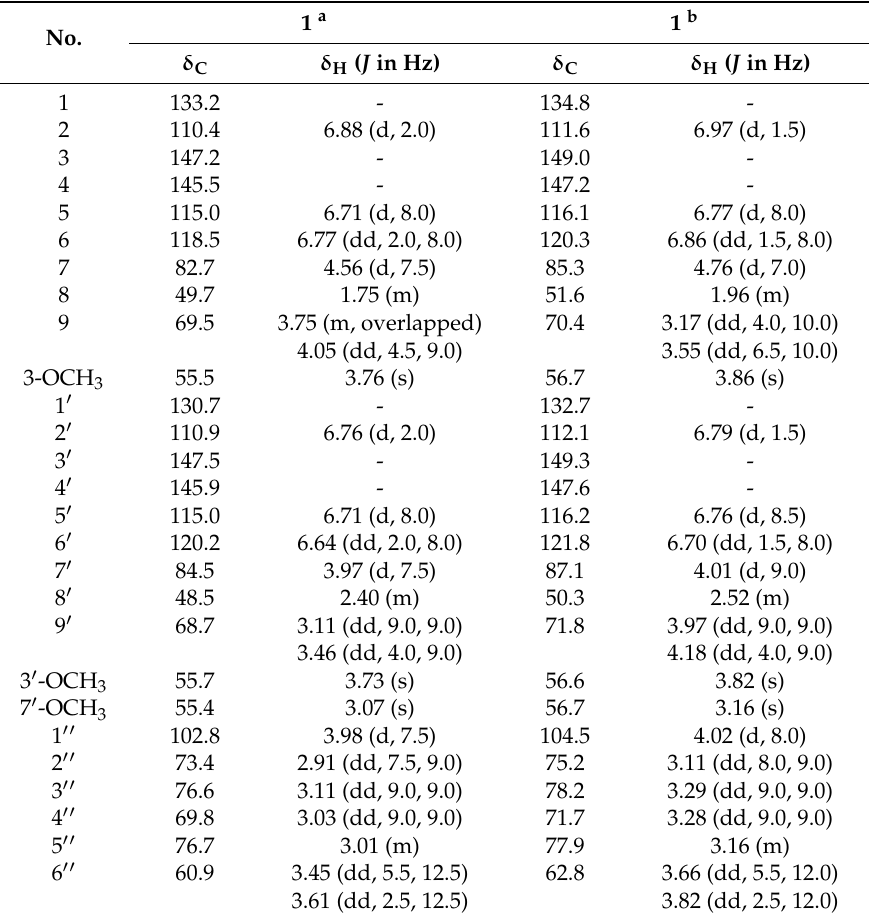
Figure 3. The main 1 H- 1 H COSY, HMBC, and NOE correlations of 1 . Table 1. The 1 H- and 13 C-NMR data of 1